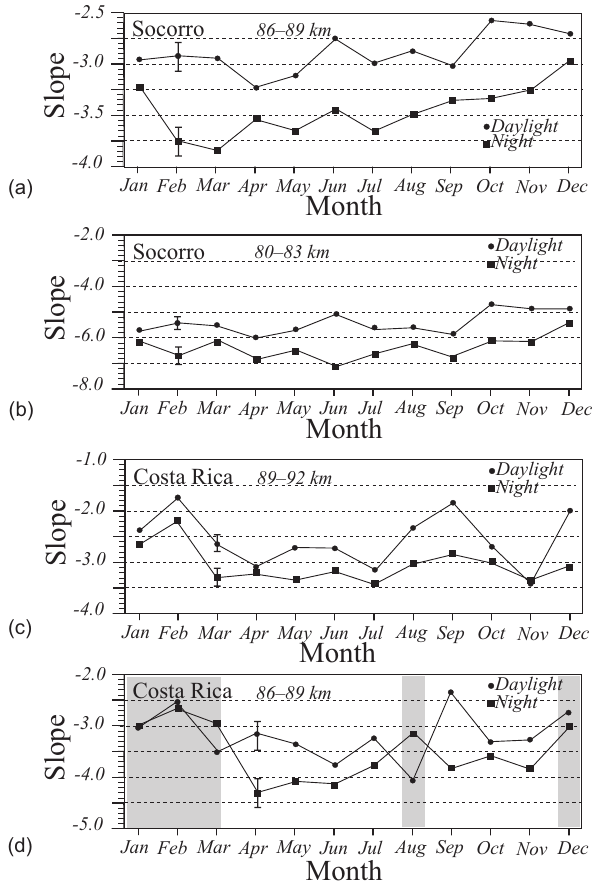
Figure 8. Plots of the slopes of the CCD measured at Socorro and Costa Rica for different selected heights. These plots are representa- tive of all data at the two sites. Representative error bars are shown on each graph. The shading in (d) shows cases where the night-time slopes are similar to, or even less negative than, the daytime ones. These regions are discussed further in the text.